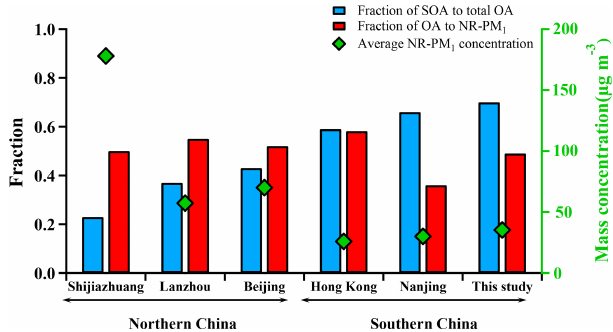
Figure 3. Comparison of submicron aerosols among several megac- ities in China during winter including Guangzhou (this study) and five other cities. Red bars represent the fraction of OA to NR-PM 1 and blue bars represent the fraction of SOA to OA. Green diamonds represent the average concentration of NR-PM 1 in each